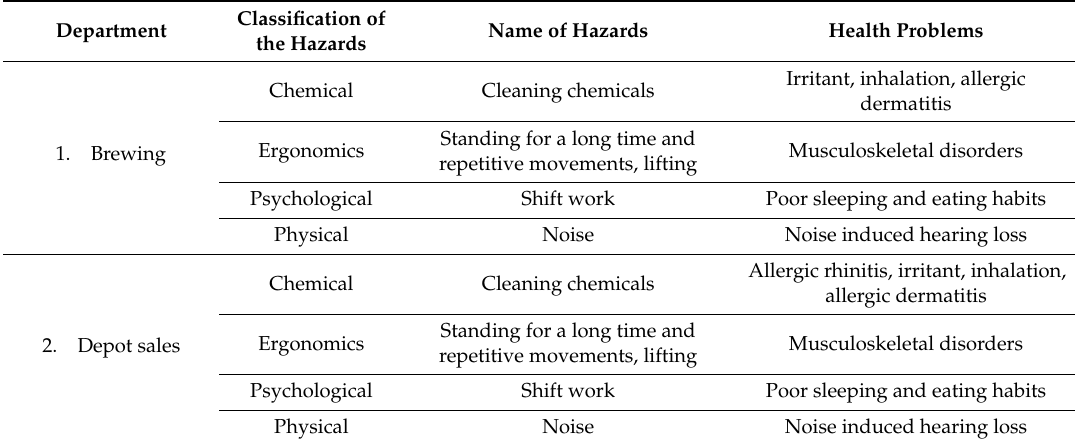
Table 2. Industry 2: Health Hazard types and classification per